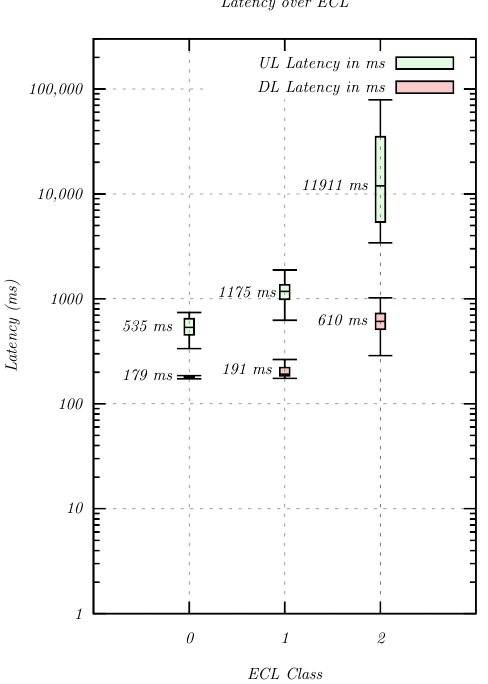
Figure 11. The influence of ECL classes on the total system latency. The median latency value is given for each ECL and transmission